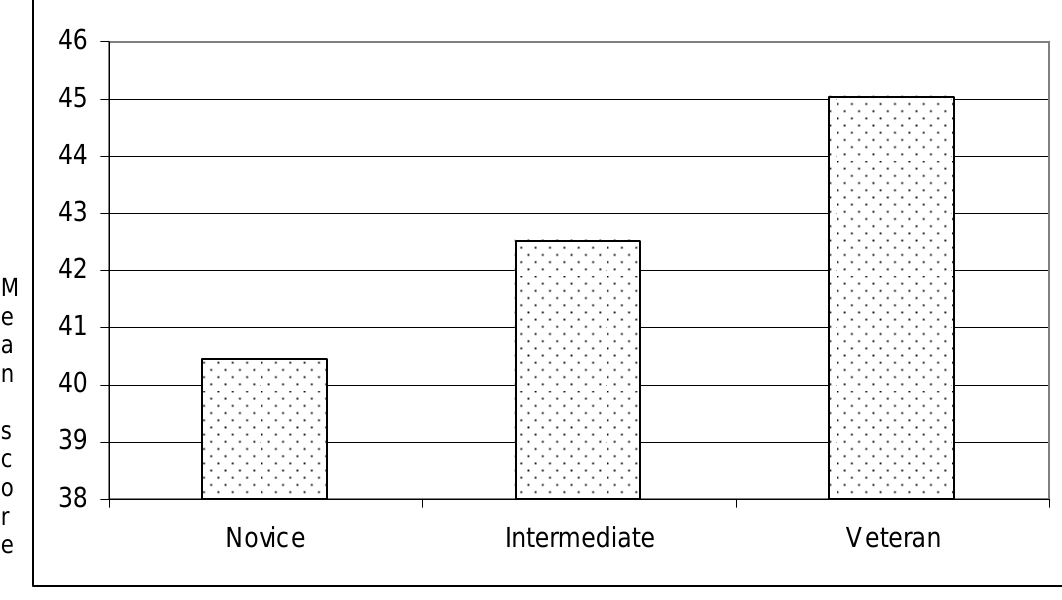
Figure 1. Overall mean scores of novice, intermediate and veteran groups in terms of inquiry-based